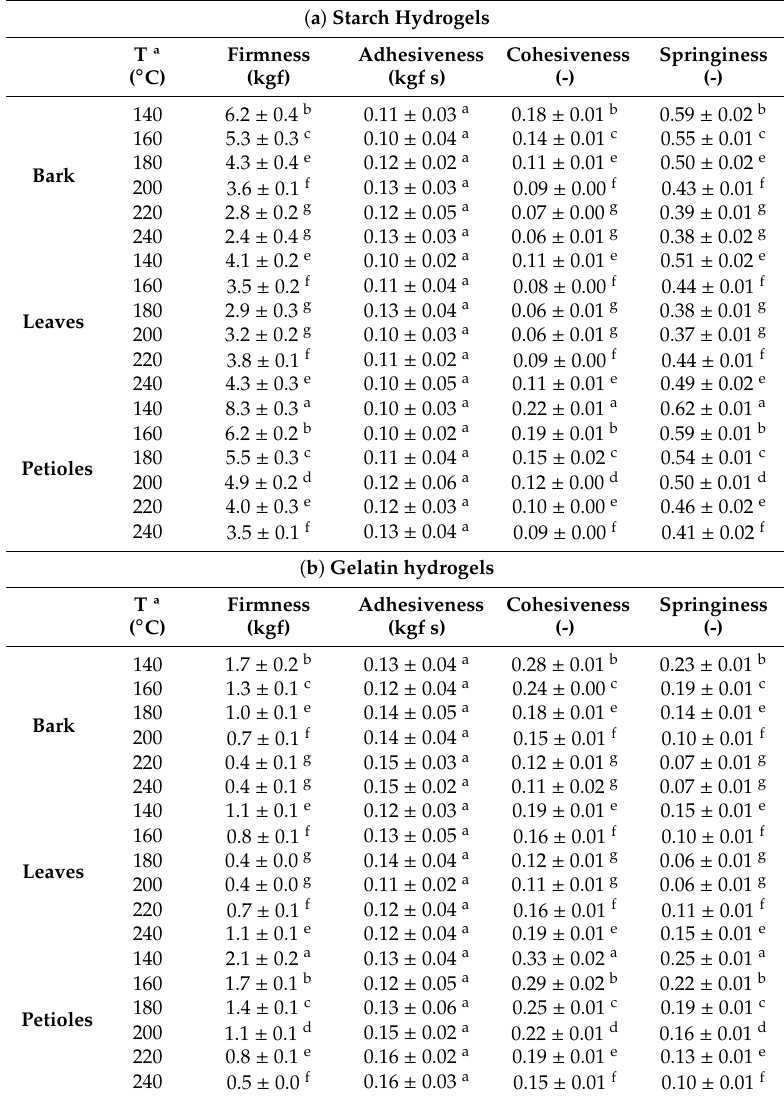
Table 3. Texture parameters for hydrogels prepared with potato starch ( a ) and gelatin ( b ) enriched with Paulownia